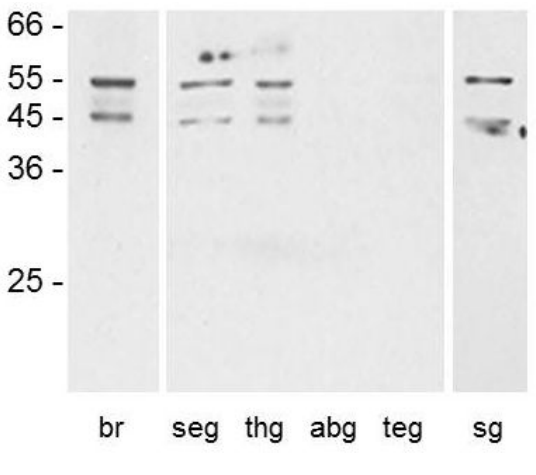
Figure 4. Western blot analysis with the anti-PeaDOP2 receptor antibody. Molecular weight marker in kilodalton. The anti-PeaDOP2-antibody (1:8000) recognized two bands of ~55 and ~46 kDa on Western blots containing membrane proteins (10 µg per lane) from brain tissue (br), subesophageal ganglion (seg), thoracic ganglia (thg), and salivary glands (sg). No bands were detected in samples from abdominal ganglia (abg) and the terminal ganglion